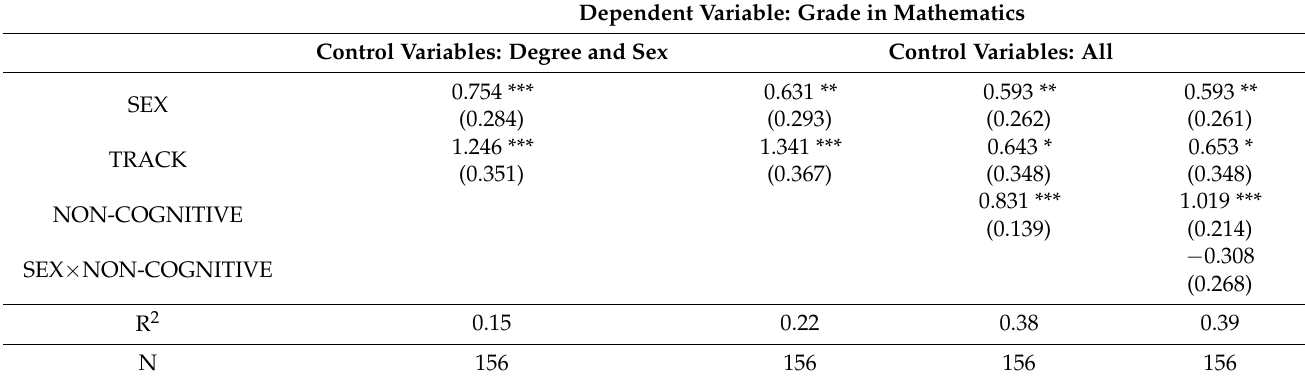
Table 5. Coefficients of linear models explaining grades (full